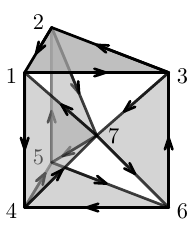
Figure 8 . The triangles and edges corresponding to (4.51). They are not embeddable on the surface of a